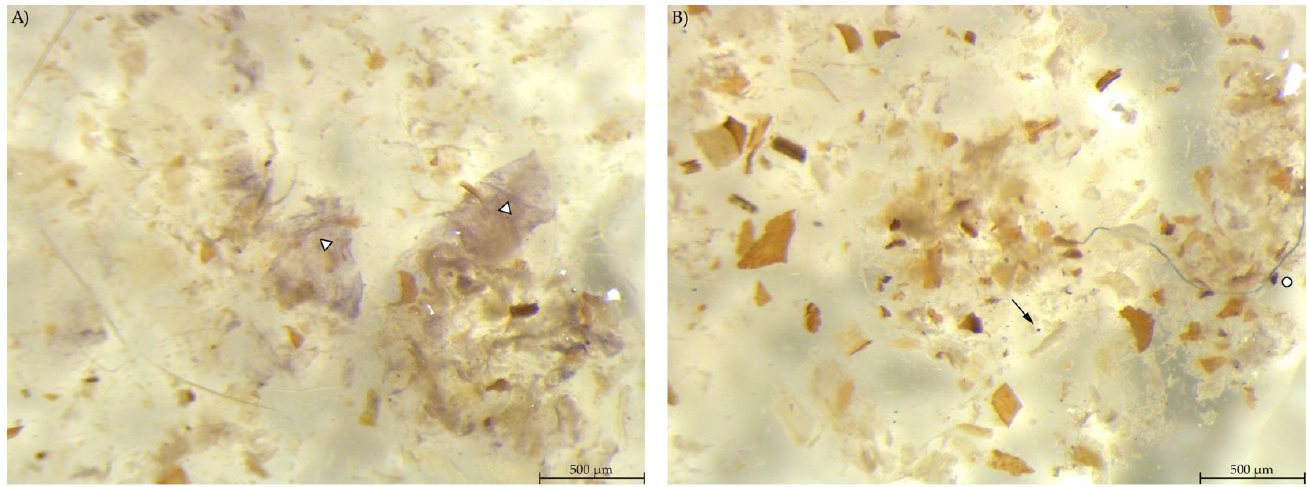
Figure 8. Colon content stained with Lugol ’ s iodine. ( A ) PEL with smears of stained starch; ( B ) EXT with hardly any stained particles visible (stereomicroscopy, 25 ×; ○ marking larger fragments of starch, ↓ marking small round particles, ∆ marking blue haze).